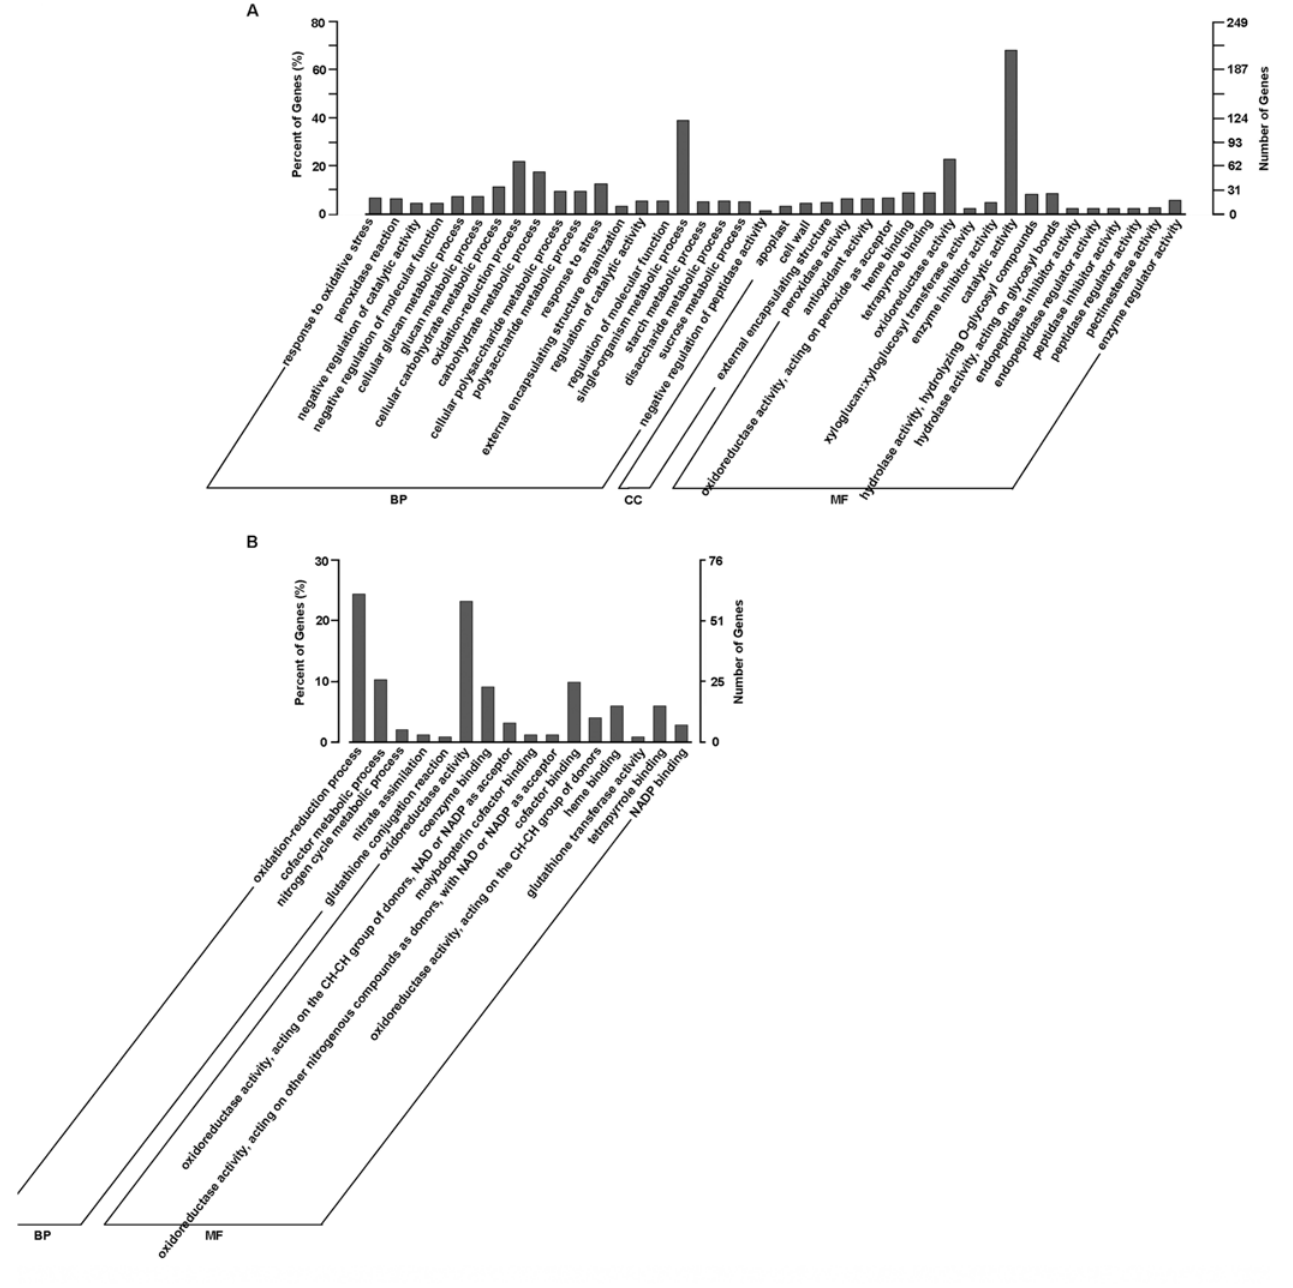
Fig 11. GO categories of biological process (BP), cellular component (CC) and molecular function (MF) for the rehydration responding genes (Rh- 6h vs . P-24h) in A . sparsifolia primary roots. (A) the rehydration inducible genes; (B) the rehydration repressed genes. The right y-axis shows the number of genes in a category, and the left y-axis indicates the percentage of a specific category of genes in that main